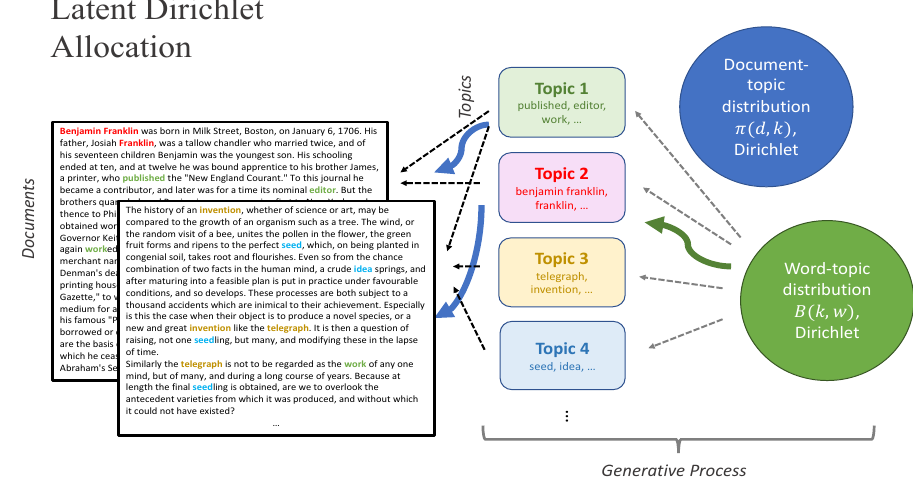
Figure 1. Representation of topic modelling using